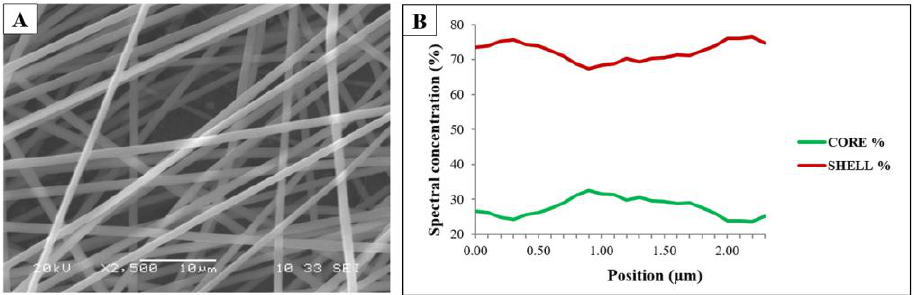
Figure 3. SEM image of the coaxially electrospun sample ( A ) and the result of the Raman mapping of the coaxially electrospun sample ( B ). the coaxially electrospun sample ( B